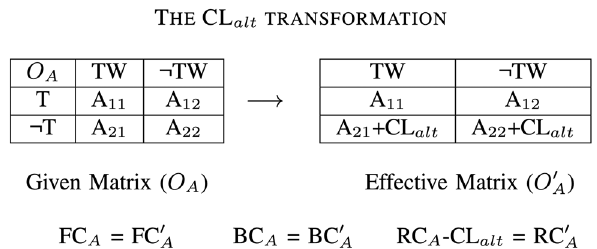
Figure 3: The CL alt transformation. CL alt only reduces RC A